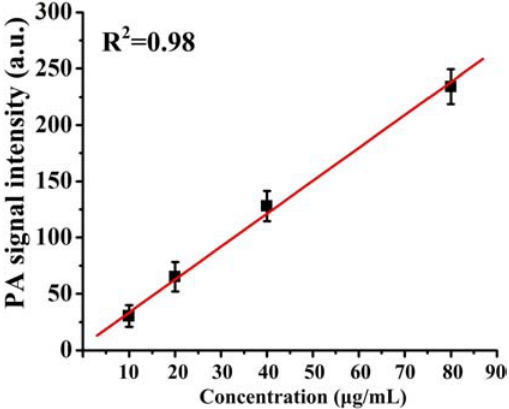
Fig. 3. The photoacoustic wave signal intensity produced by GO-ICG was linearly related to the concentration of GO-ICG ( R 2 ¼ 0 : 98).